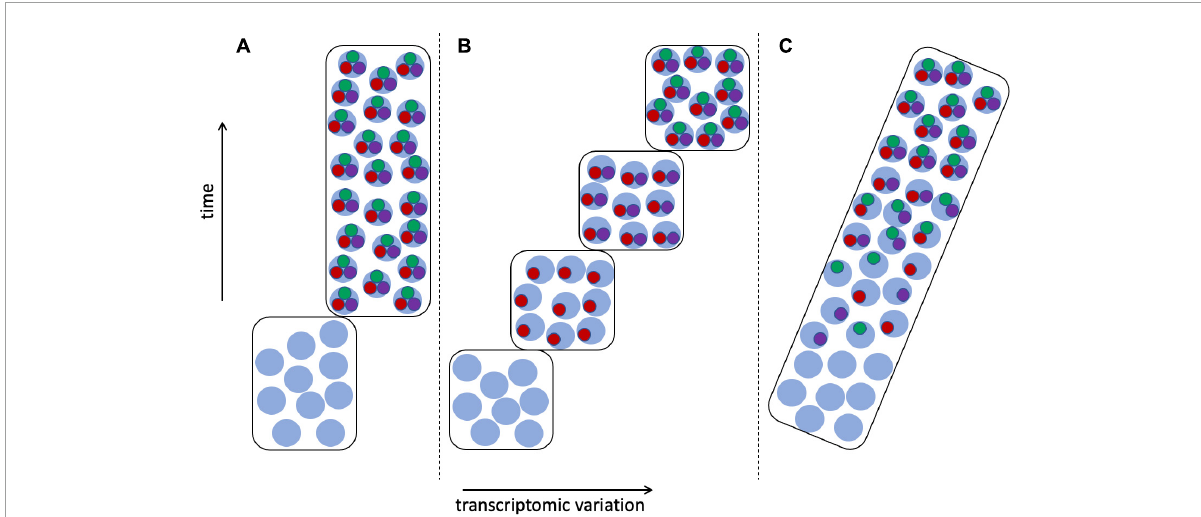
FIGURE7 Transcriptomic variation of differentiating cells. Transcriptomes as in Figure 6 , cell type 1: with stem cell transcriptomes shown as light blue circles, mature cells expressing apomeres of all three terminal selector TFs (red, green, and purple circles), and cells at intermediate stages of differentiation having 1–2 apomeres. (A) The CoRC defining the mature cell type is assembled in a single step, resulting in clear demarcation of two cell types. (B) Stepwise assembly of the CoRC, in the order TF1, TF2, and TF3, resulting in several distinguishable states, each of which could be considered a cell type. (C) Random assembly of the CoRC during differentiation would produce more gradual or continuous transcriptomic change from stem to mature cell